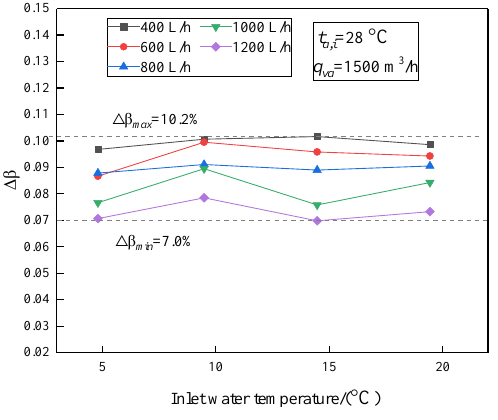
Figure 9. Variation of Δβ with inlet water temperature under different wate r flow rates.